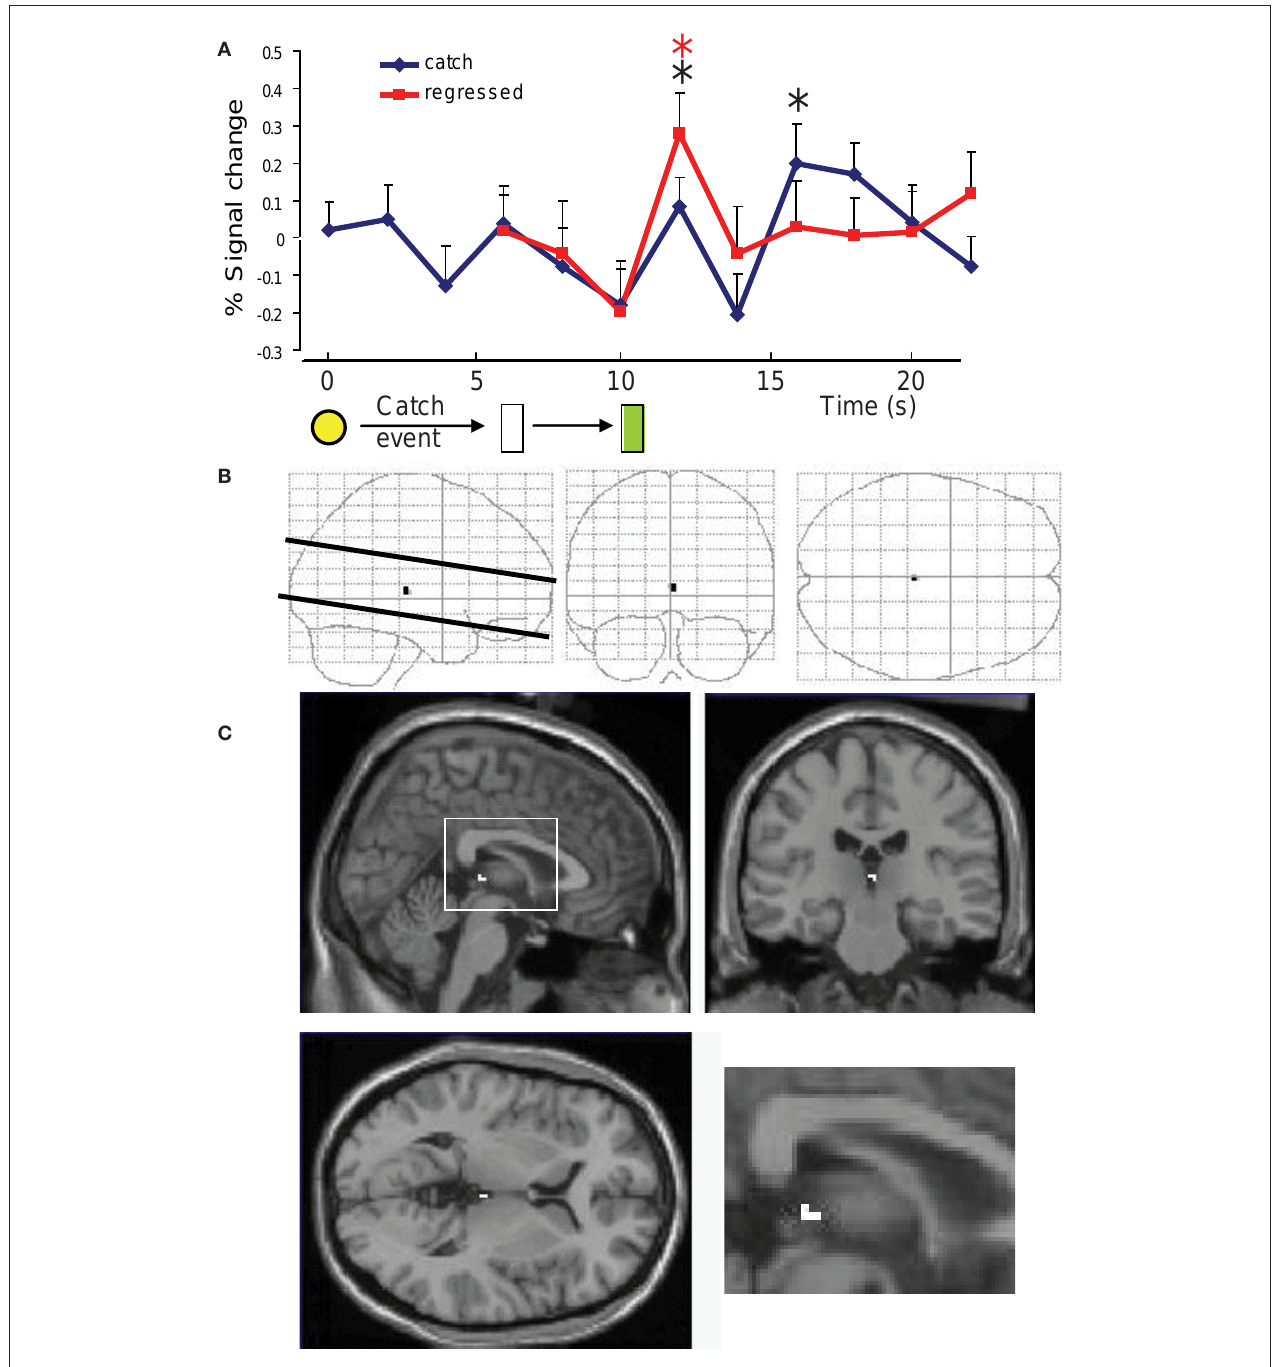
FIguRe  | Habenular region activity at catch events. (A) Time course of the activity of all voxels contained within habenular bounding boxes during catch events (black trace) and the activity of those voxels after regressing out the time course from the same voxels during normal events in runs 3 and 4, shifted 4 s to align juice